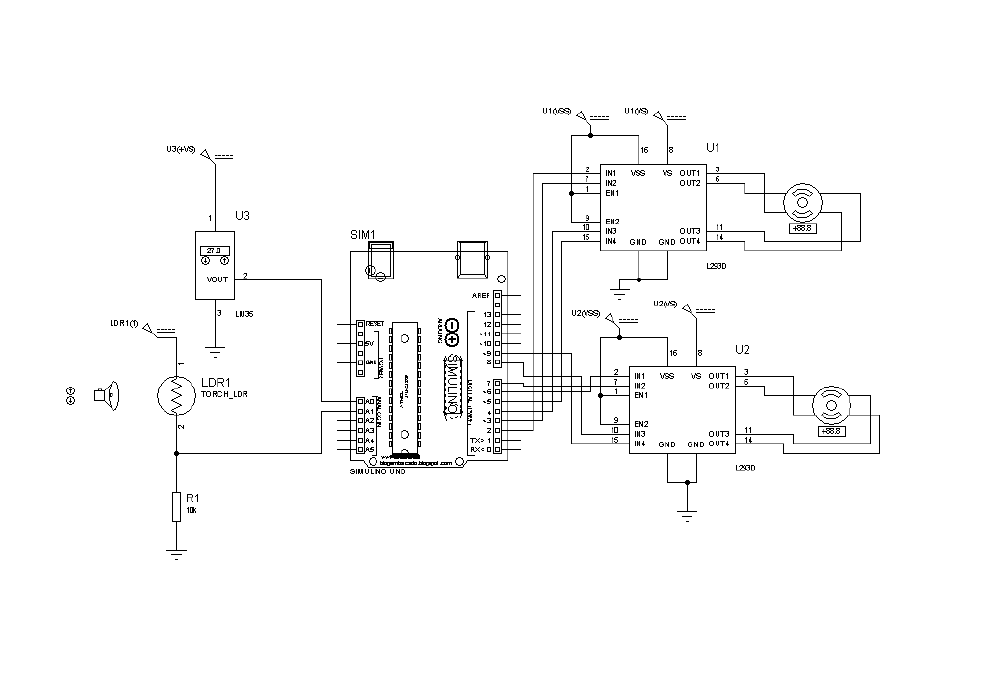
Fig. 4. Simulation of the complete electrical assembly of our experiment under Proteus ISIS.